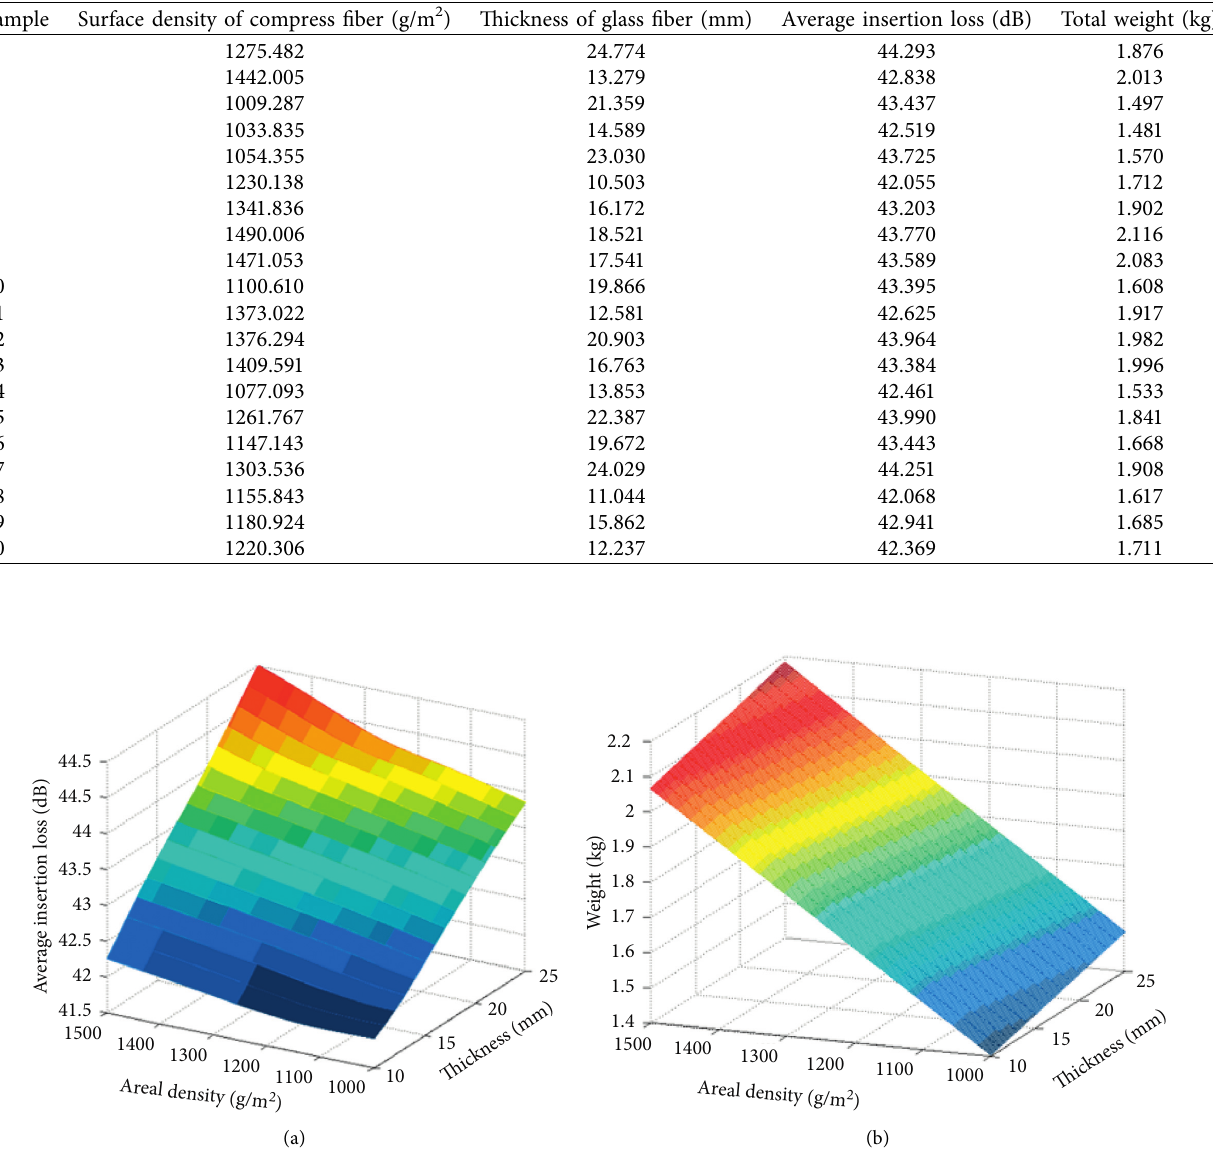
Figure 14: Approximate model of acoustic package for new material. (a) Average insertion loss, width, and surface density. (b) Weight, thickness, and surface